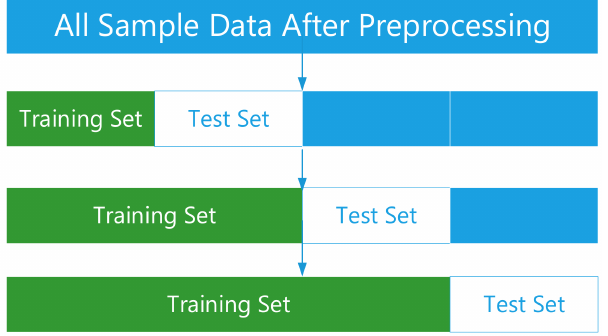
Figure 4. Evaluation